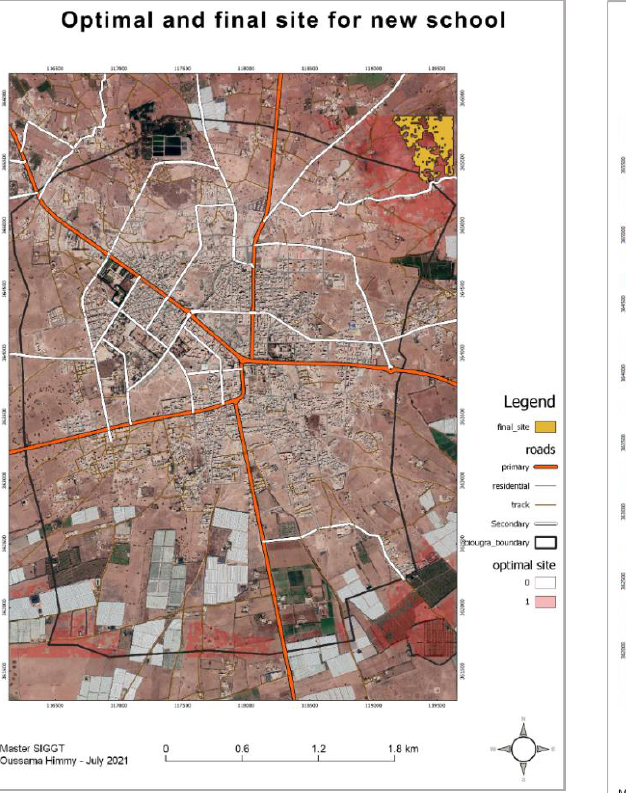
Figure 10 . The optimal and final site for building a new school